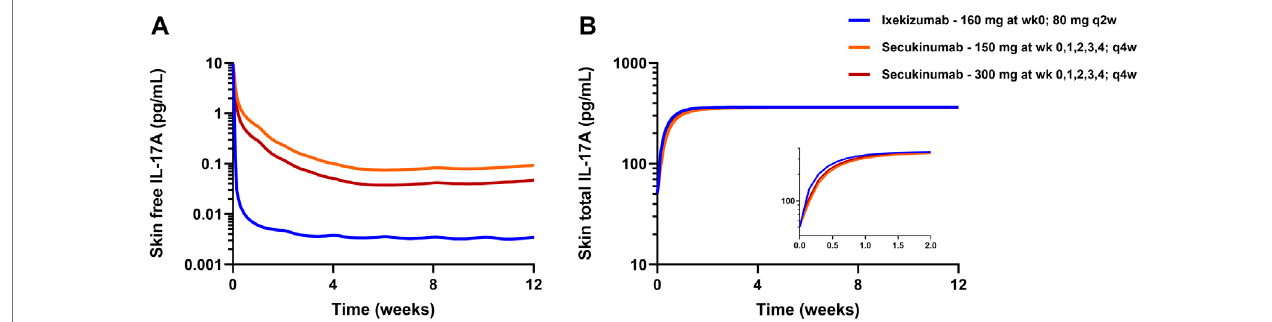
FIGURE 5 | mPBPK model-predicted free IL-17A lowering (A) and total IL-17A (B) in psoriatic skin following secukinumab or ixekizumab. Solid lines represent model simulations.